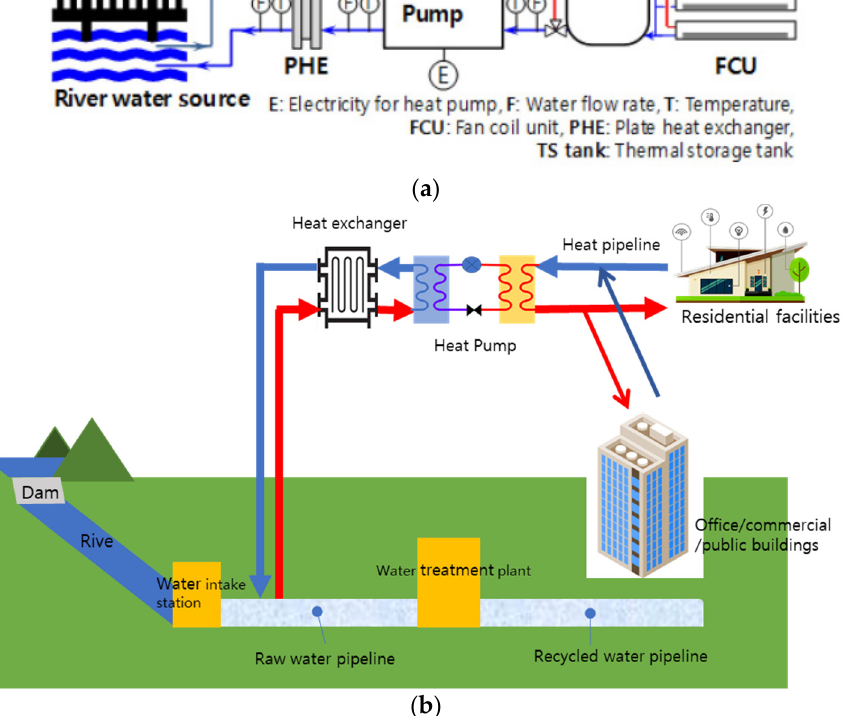
Figure 1. Schematic diagram of ( a ) a river water-source heat pumps system and ( b ) a concept map for utilizing hydrothermal energy along the water supply pipeline.